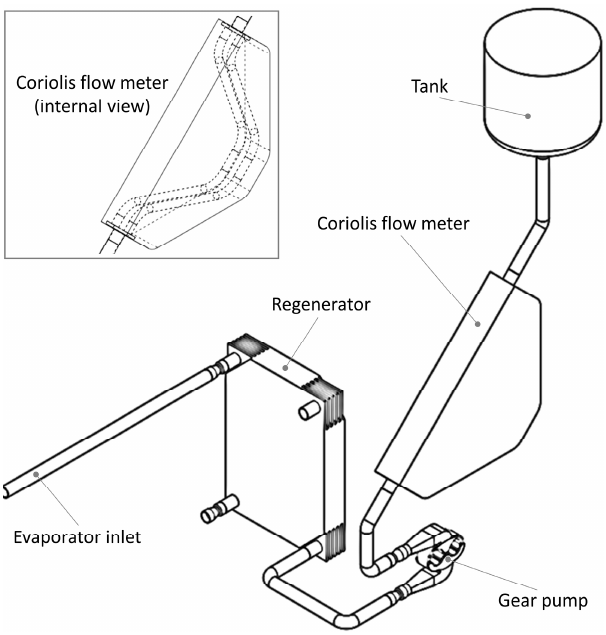
Figure 1. The virtual model of the micro-ORC system: tank, Coriolis flow meter, gear pump, and regenerator. and